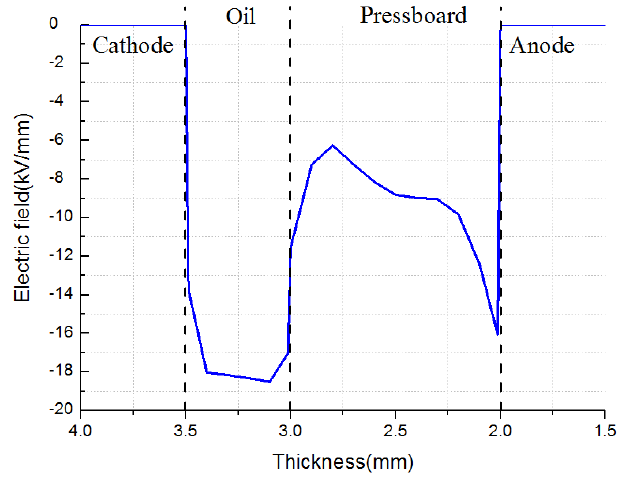
Figure 36. Electric field of fresh oil and oil ‐ impregnated pressboard adding space charge for polarity reversal operation time of the 60 s.